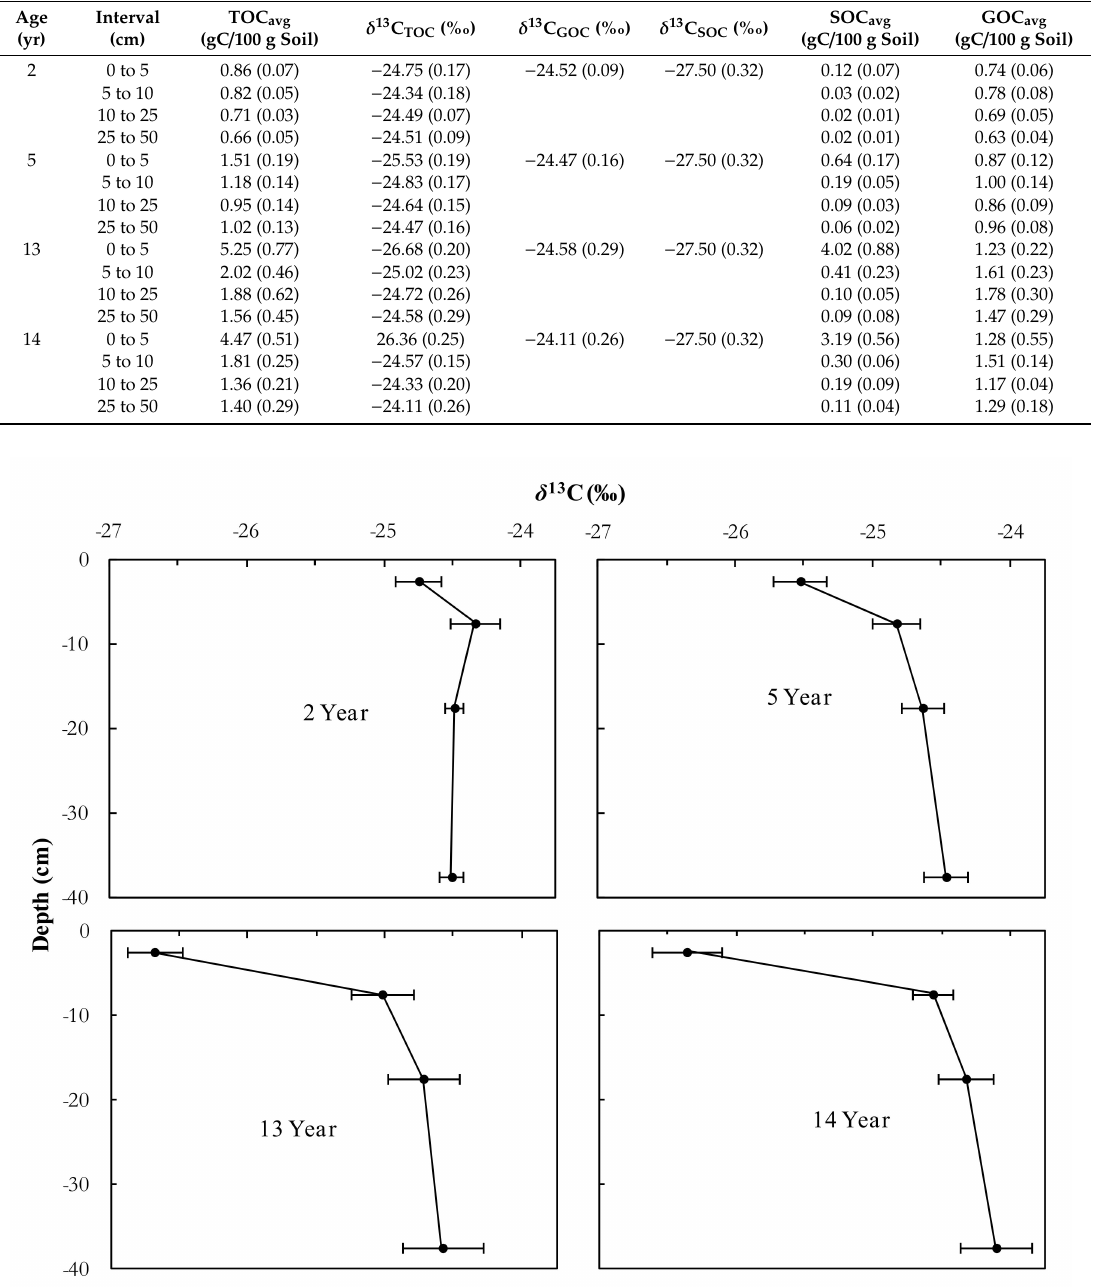
Figure 7. ARRI δ 13 C vertical profiles. Uncertainty reflects ± 1